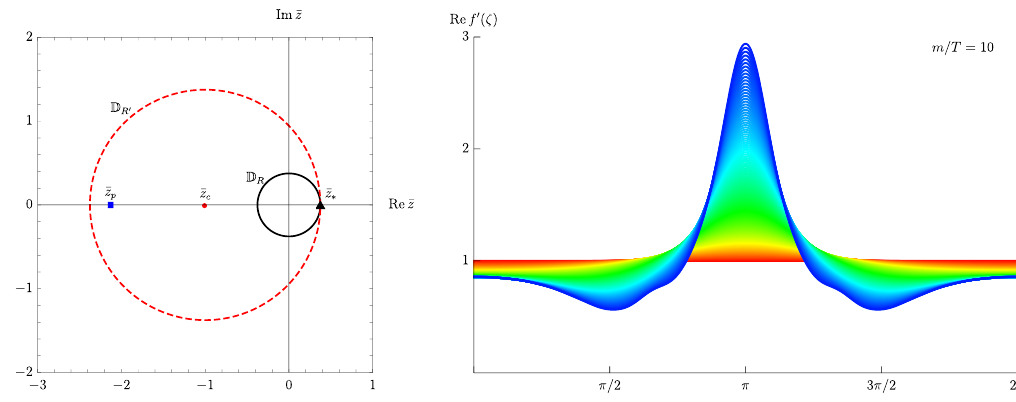
Figure 4 . Left panel: a plot showing the convergence disk domain D R (black solid line) and an example of a larger disk U = D R 0 (red dashed line) where ω ( z ) at m/T = 10 is still univalent. The centre of U = D R 0 is at ¯ z c = − 1 , the location of the pole-skipping point is at ¯ z p and the critical point limiting holomorphicity (convergence) is at ¯ z ∗ = R/ (2 πT ) 2 . Right panel: here, we show that the dispersion relation is indeed univalent in U = D R 0 by mapping it to the unit disk | ζ | < 1 via the conformal map (4.9) and plotting Re f 0 ( ζ ) . As can be seen, Re f 0 ( ζ ) > 0 over the entire U → D . Thus, in principle, the stronger log bound on diffusion (2.19) could also be applied here. The colour scheme is the same as in figure